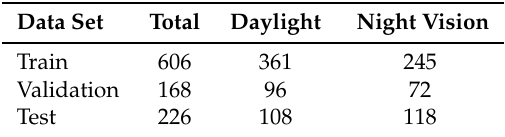
Table 1. Data set statistic for the 1000 randomly selected and annotated images: The images of the test set are taken from a different camera than the images of the training and validation